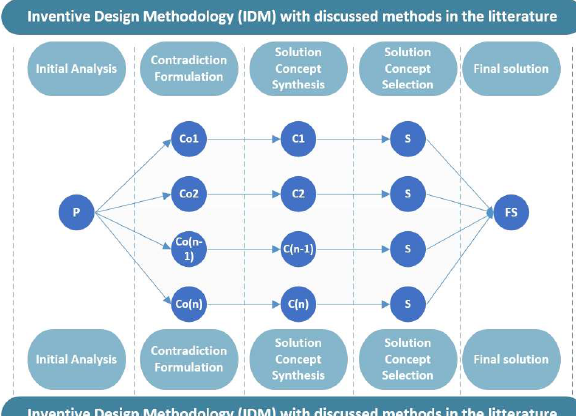
Figure 6. IDM with other discussed methods in the literature